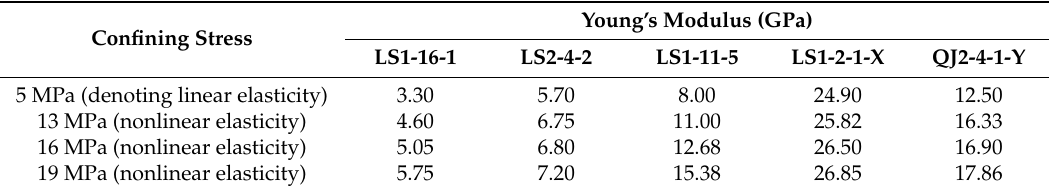
Table 3. Calibrated Young’s modulus values used in the quantification numerical study.